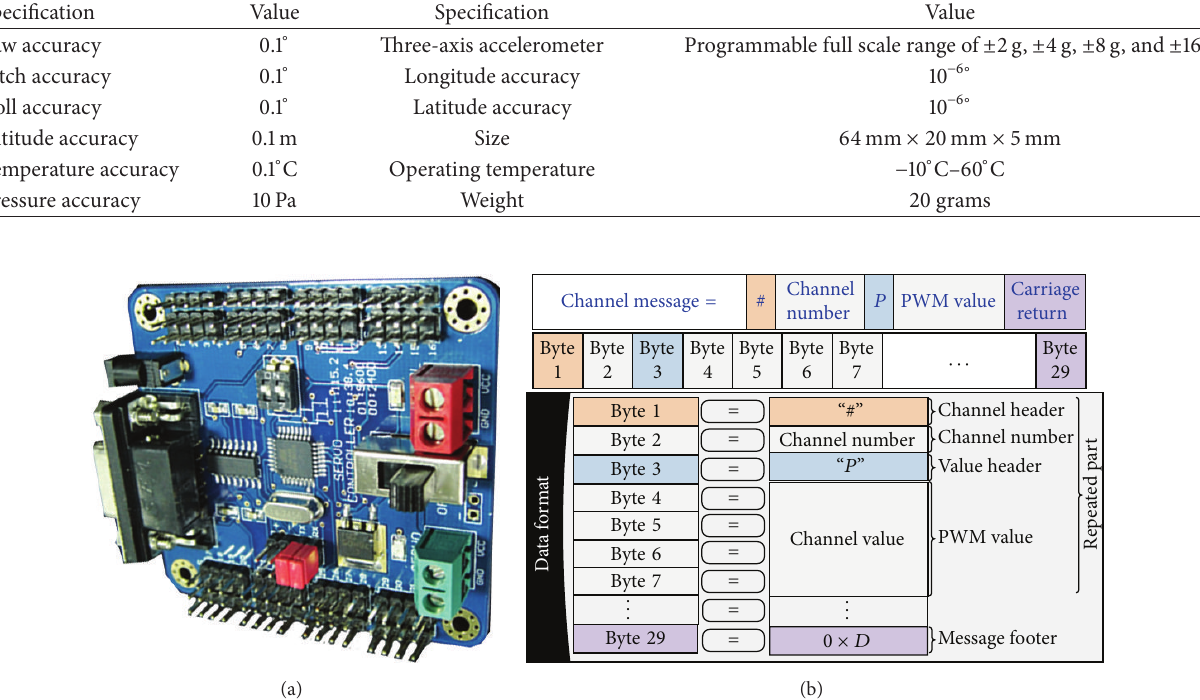
Figure 3: Multiple channel PWM controller. (a) Printed Board Layout [9], (b) four-channel data format